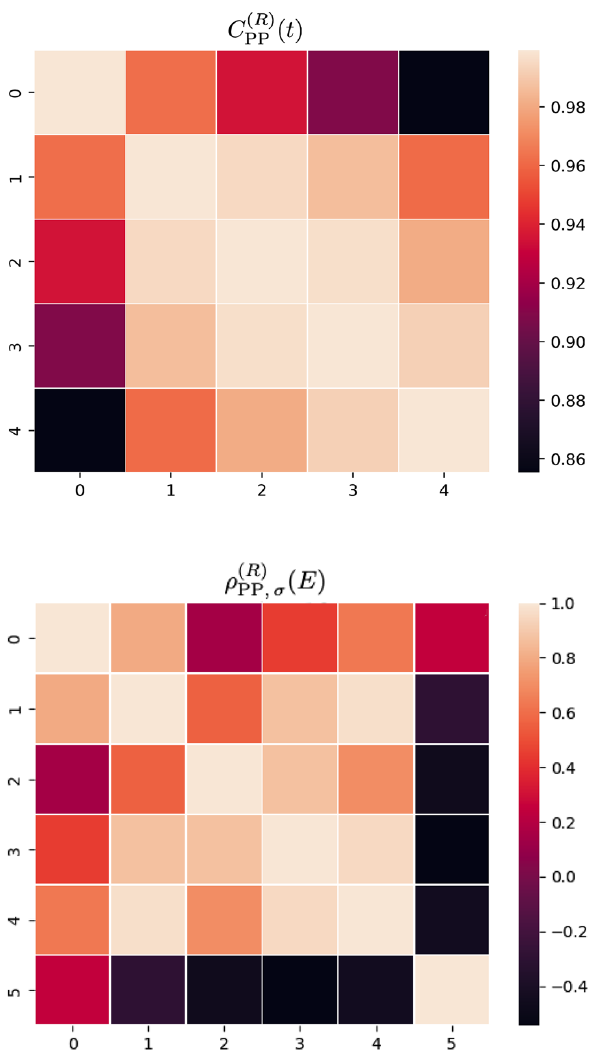
( t ) at five PP ( 2AS ) ( E ) evaluated PP ,σ ( 2AS ) ( t ). Thepointsatwhichthespectral PP ( 2AS ) from lattice correlators. PP